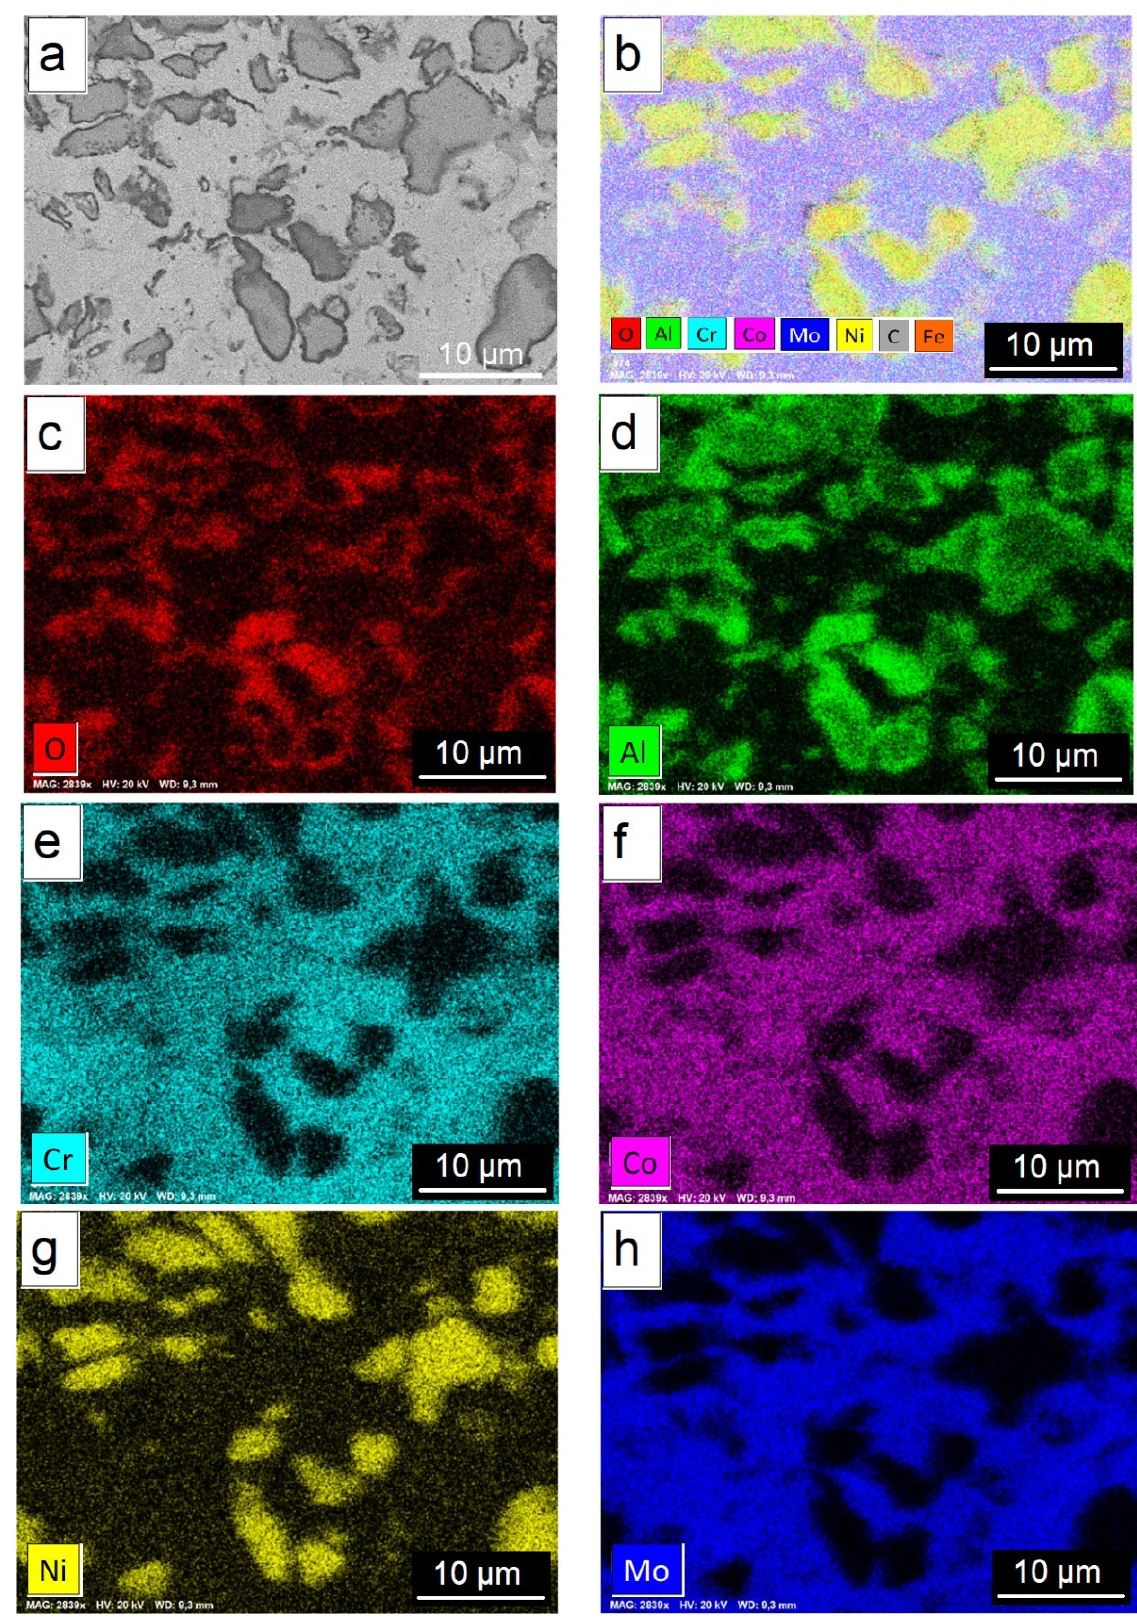
Figure 6. Elements distribution map in an alloy without nanoparticles: ( a ) microstructure, ( b ) all elements distribution, ( c ) O, ( d ) Al, ( e ) Cr, ( f ) Co, ( g ) Ni, ( h ) Mo.